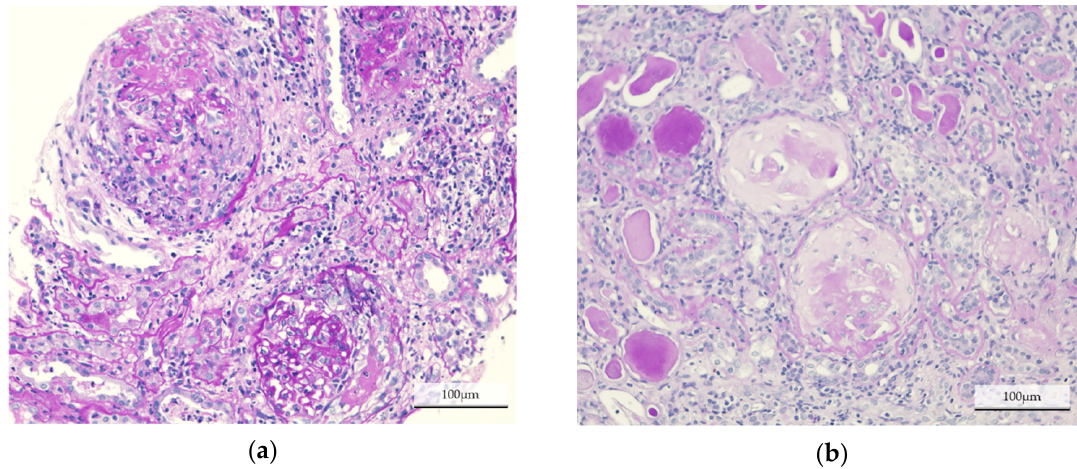
Figure 7. Histological findings in each group. Representative images of Periodic acid-Schiff staining on paraffin-embedded kidney sections, from patients in ( a ) the temporary hemodialysis (HD) group, and ( b ) the maintenance HD group. Cellular crescentic glomeruli were dominant in the temporary HD group, whereas most of the glomeruli were globally sclerotic in the maintenance HD group.